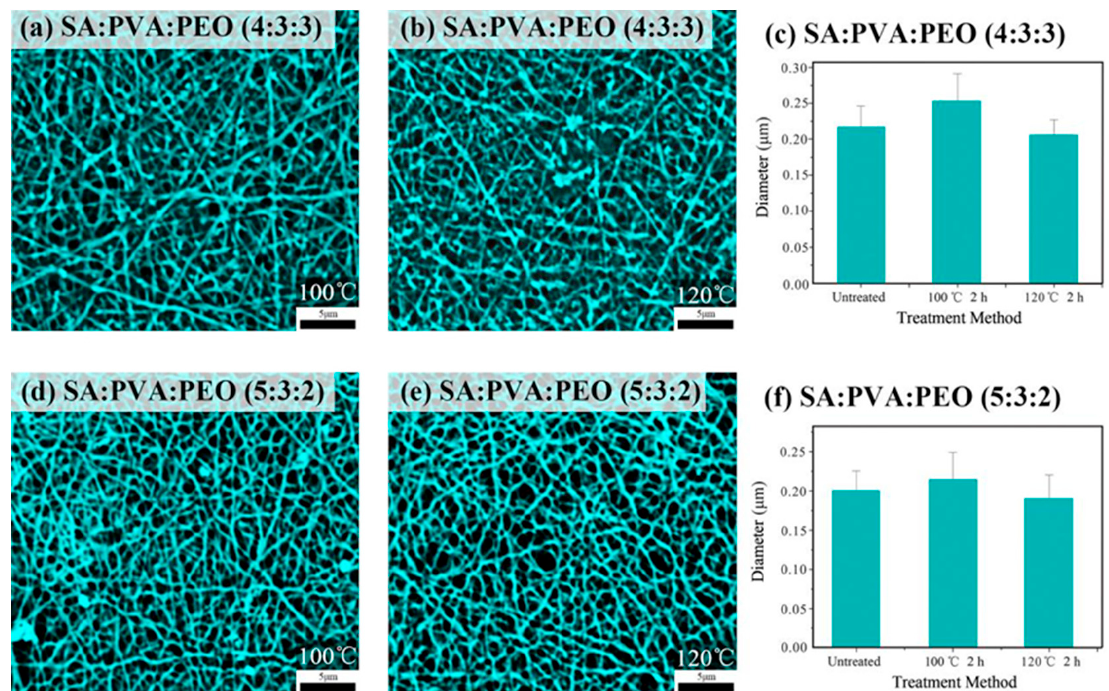
Figure 5. Surface morphological structure of SA/PVA/PEO 4:3:3 MFMs treated at ( a ) 100 °C and ( b ) 120 °C. ( c ) Average diameter of SA/PVA/PEO 4:3:3 MFMs treated at different temperatures. Surface morphological structure of SA/PVA/PEO 5:3:2 MFMs treated at ( d ) 100 °C and ( e ) 120 °C. ( f ) Average diameter of SA/PVA/PEO 5:3:2 MFMs treated at different temperatures.